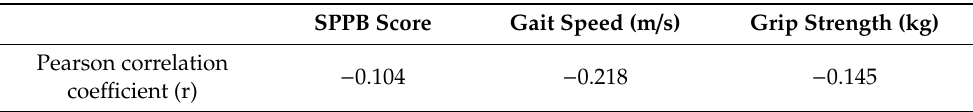
Table 2. Correlation between increasing baseline frailty index and other baseline physical functioning assessments. SPPB Score Gait Speed (m / s) Grip Strength (kg) Pearson correlation − 0.104 − 0.218 − coe ffi cient (r)